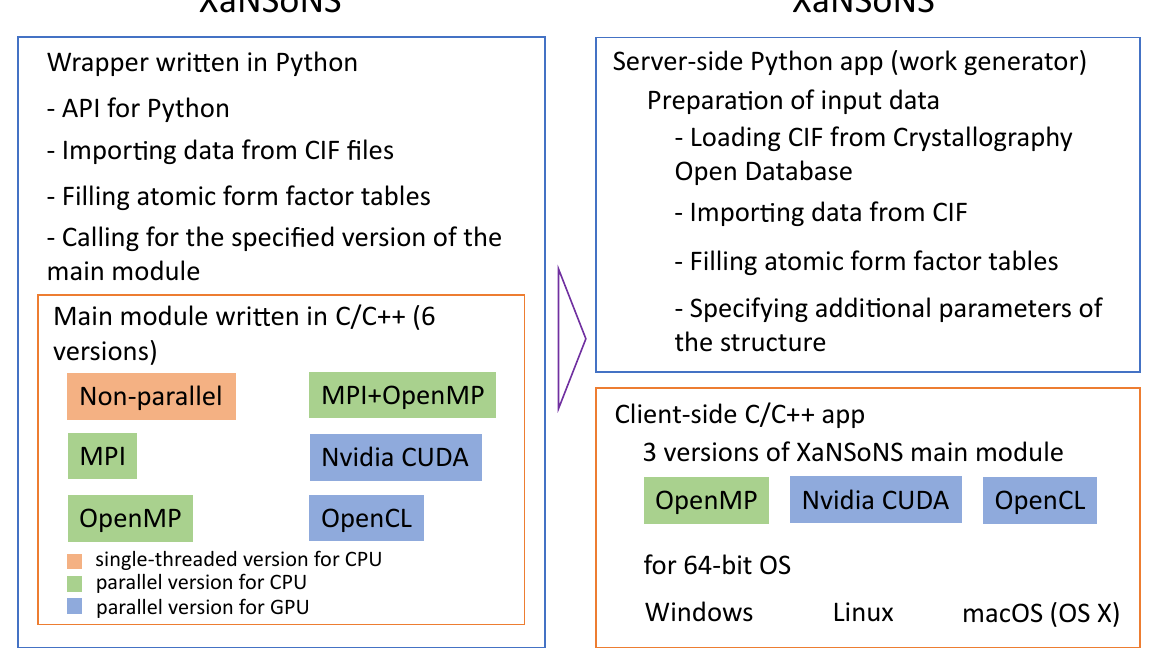
Figure 2: Transforming XaNSoNS into the BOINC